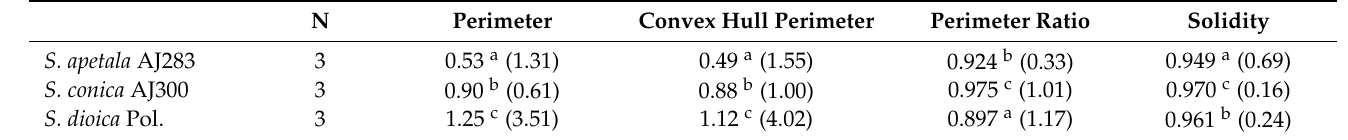
Table 2. Values of solidity and perimeter ratio (perimeter of the convex hull/ perimeter of the image) in the average silhouettes and as mean of three seeds for the lateral views of the seed images of S. apetala AJ283, S. conica AJ300 and S. dioica Pol. Values marked with the same superscript letter in each column correspond to populations that do not differ significantly at p < 0.05 (Campbell and Skillings’s test). N indicates the number of seeds